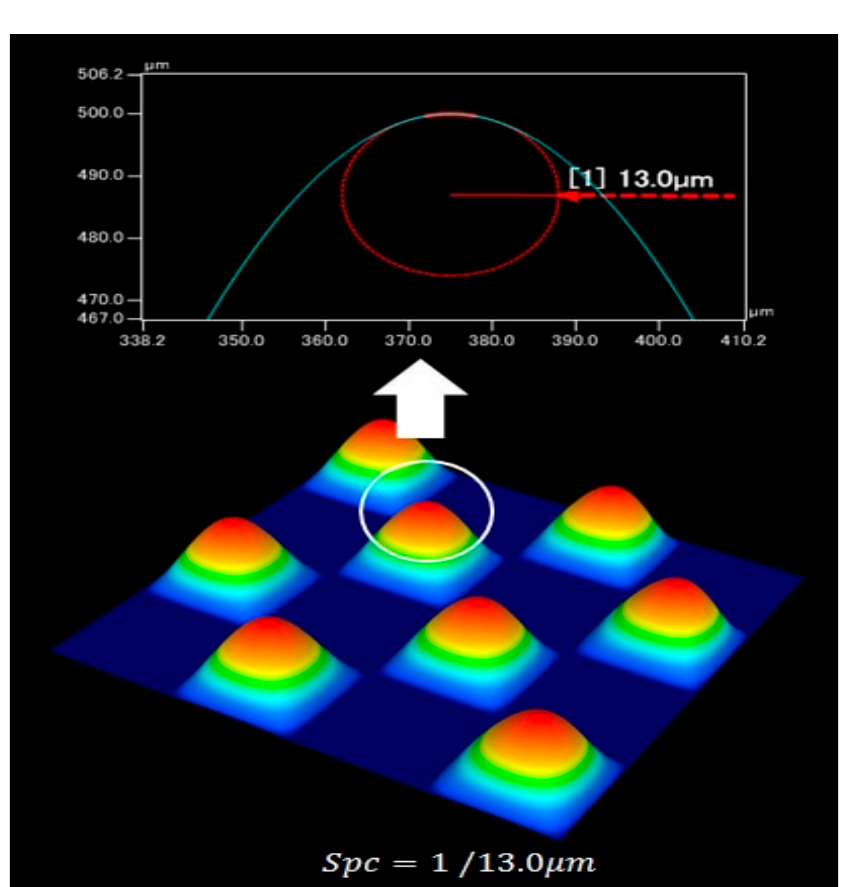
Figure 9. Arithmetic mean curvature of the crest.